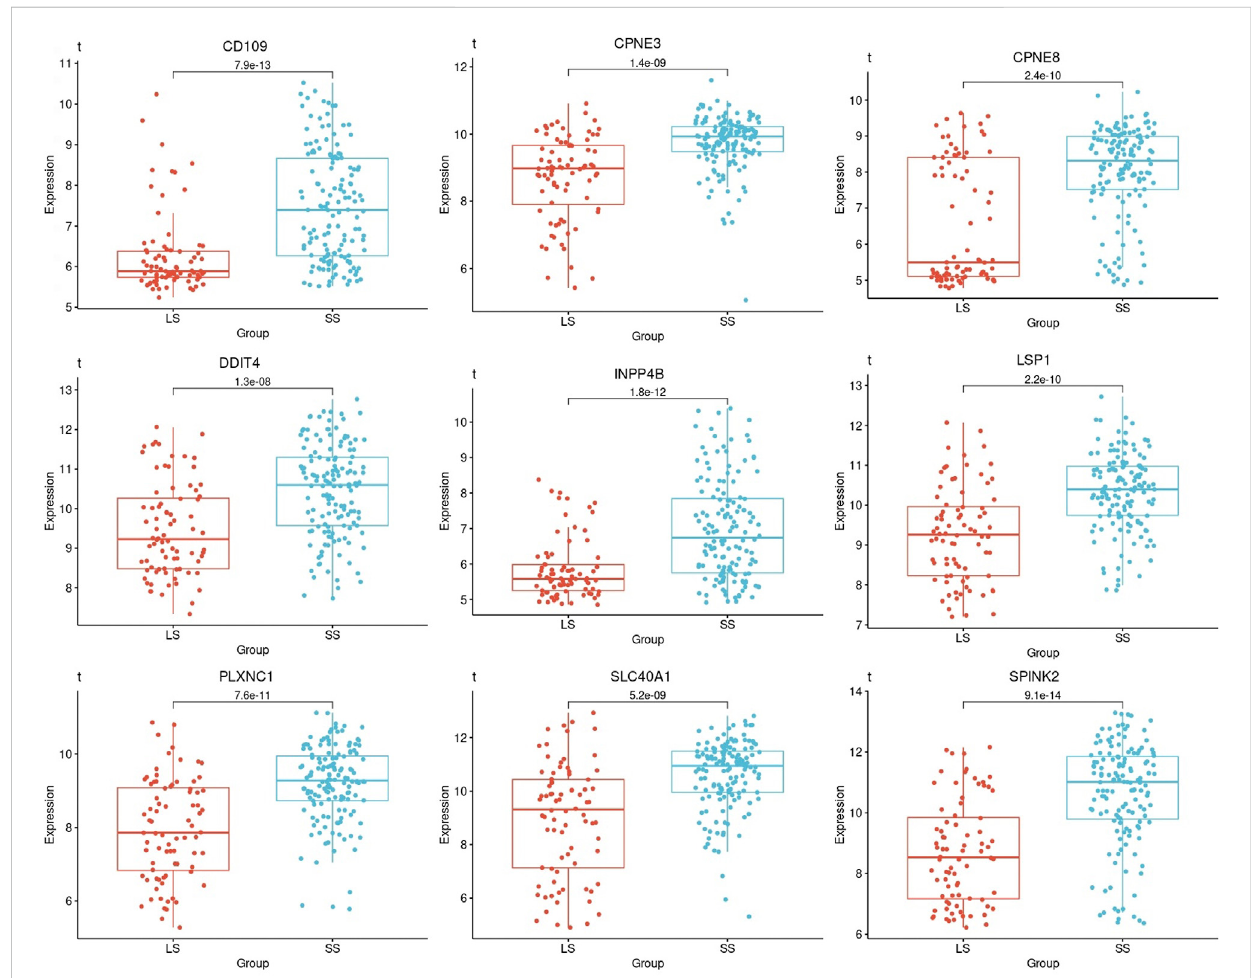
FIGURE 5 Boxplots based on the survival times of the prognostic genes in AML patients. A boxplot was constructed with the gene expression pro fi le of each prognostic gene in all the samples that were categorized as short- and long-term